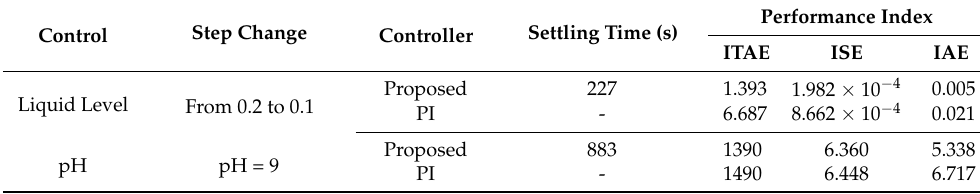
Table 6. The performance comparison between the proposed and PI